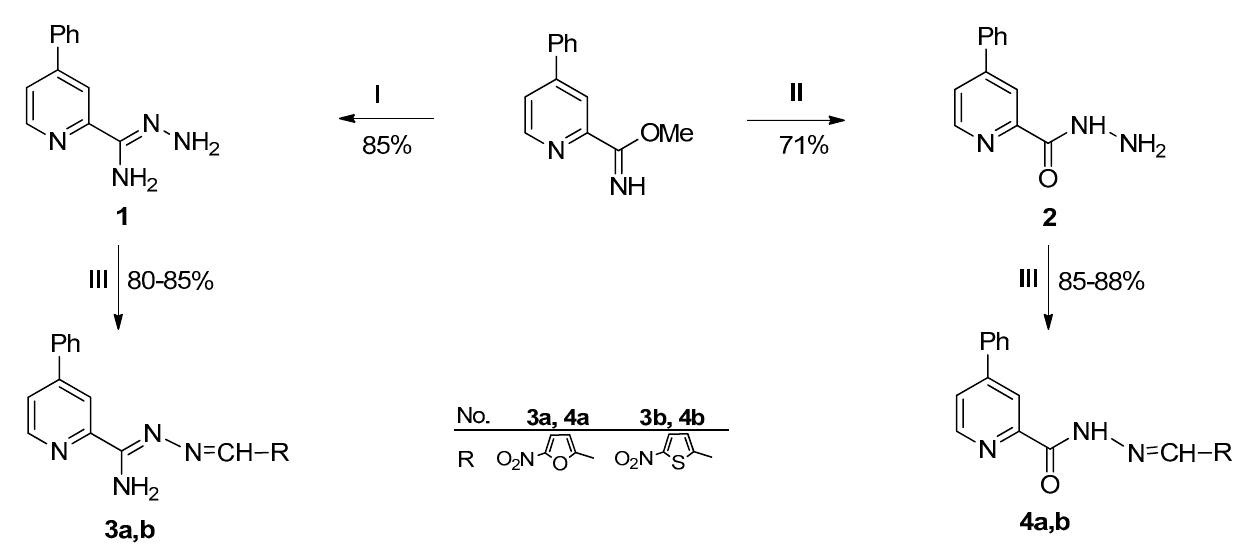
Figure 3. Synthesis of 4-phenylpicolinonitrile derivatives 1 – 4a , b . Reagents and conditions: (I)